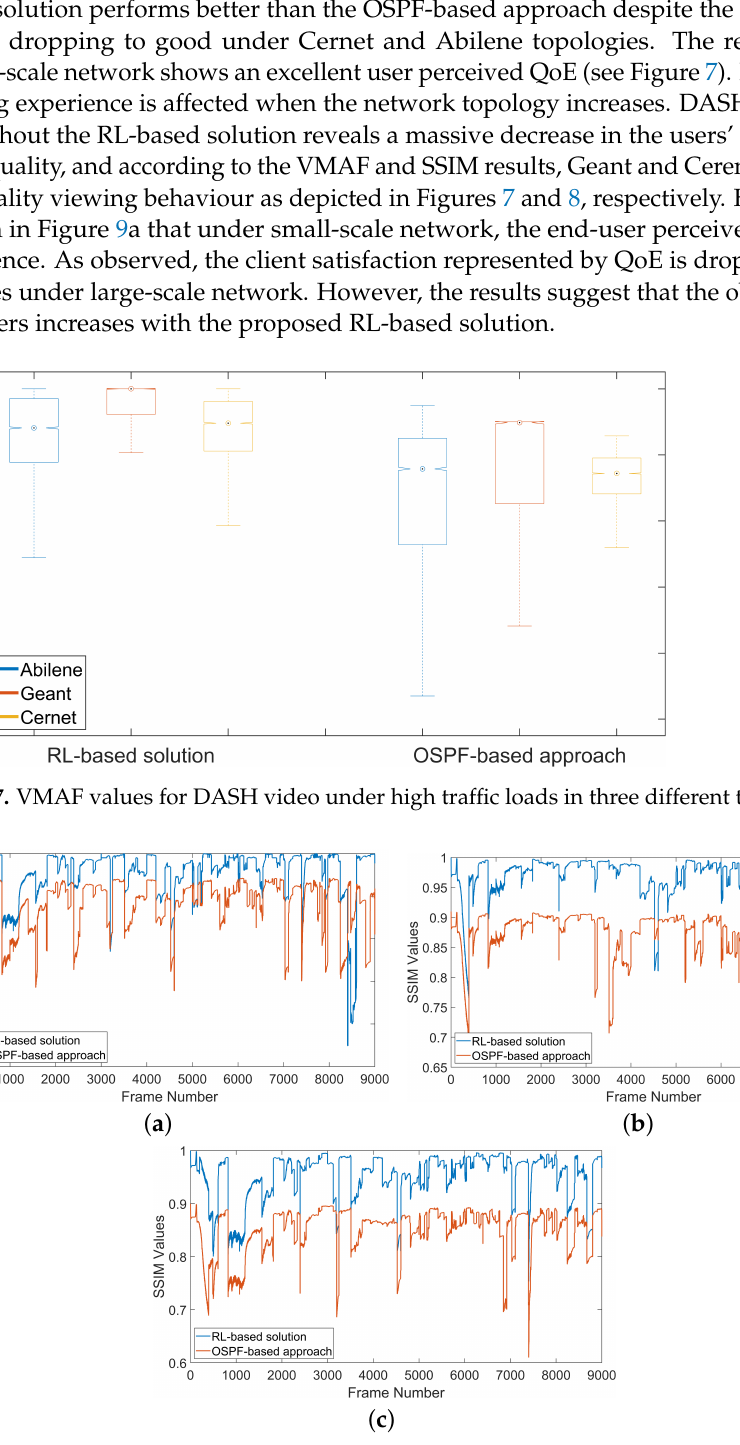
Figure 8. SSIM values for DASH video under high traffic loads in three different topologies. ( a ) Abi- lene; ( b ) Geant; ( c )